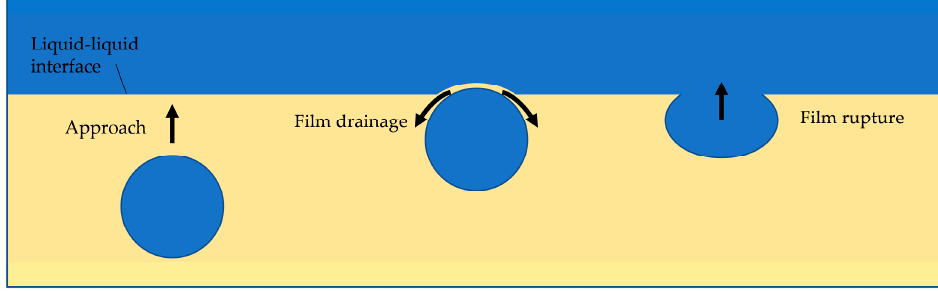
Figure 3. Schematic representation of the coalescence of a droplet with the phase boundary [25].